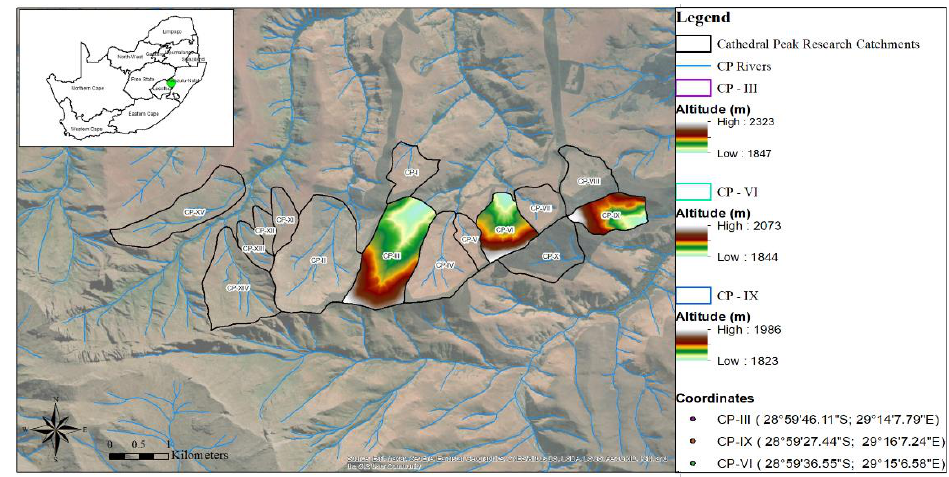
Figure 1. Locality of the catchments selected for the study.